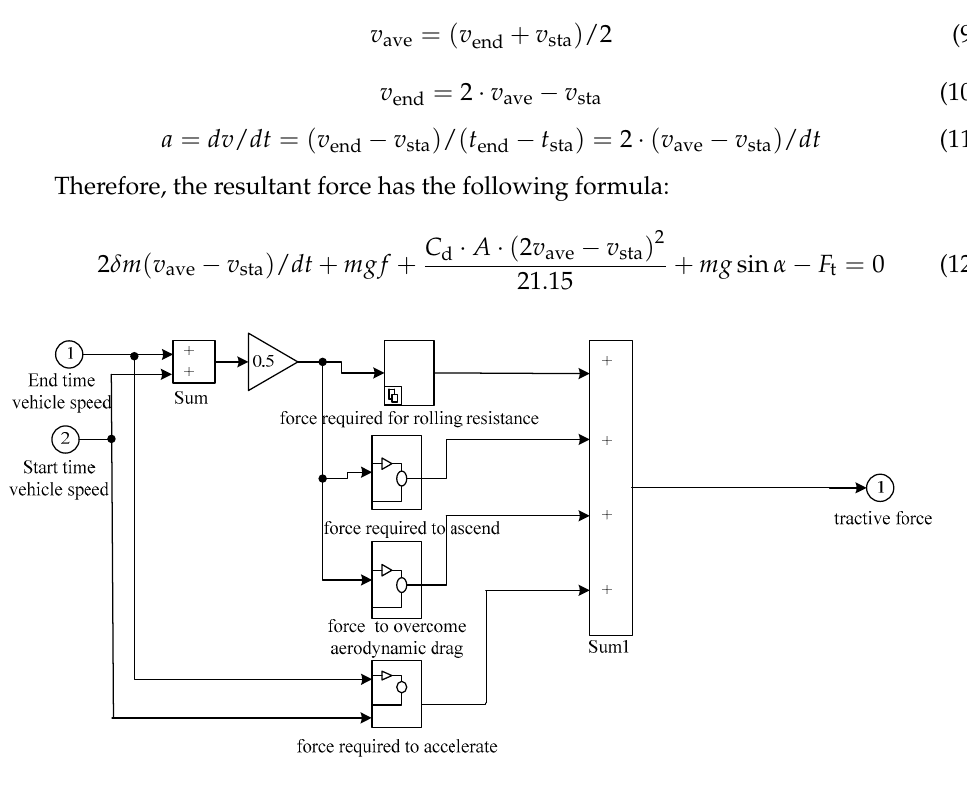
Figure 1. Vehicle resistance calculation model.